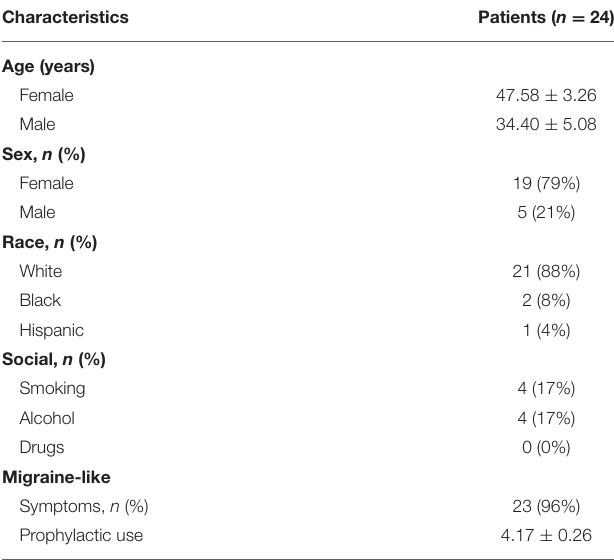
TABLE 1 | Demographics and clinical characteristics.